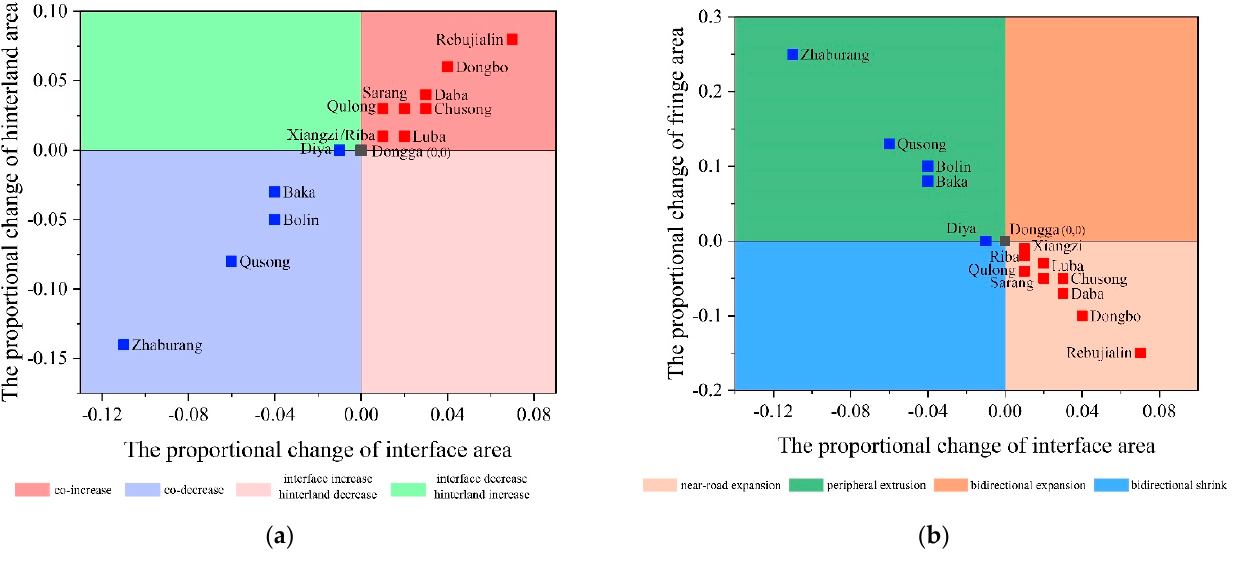
Figure 9. The change of spatial division proportion of rural settlement. ( a ) The interface and the hinterland. ( b ) The interface and the fringe.